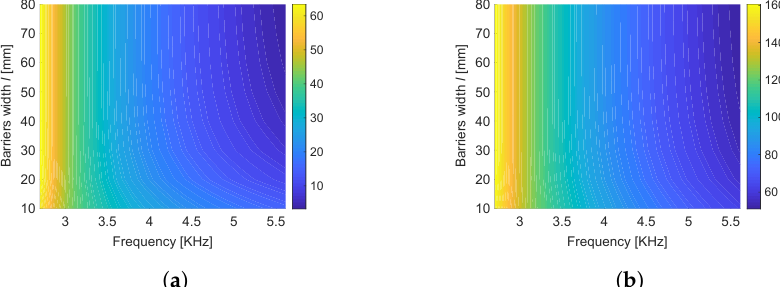
Figure 8. First ( a ) and second ( b ) optimal ˜ d n plotted with respect to the the frequency ω inside the first band gap and the width l of the